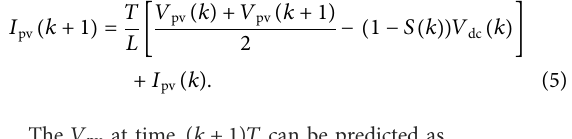
FIGURE 4 V-I characteristic of PV